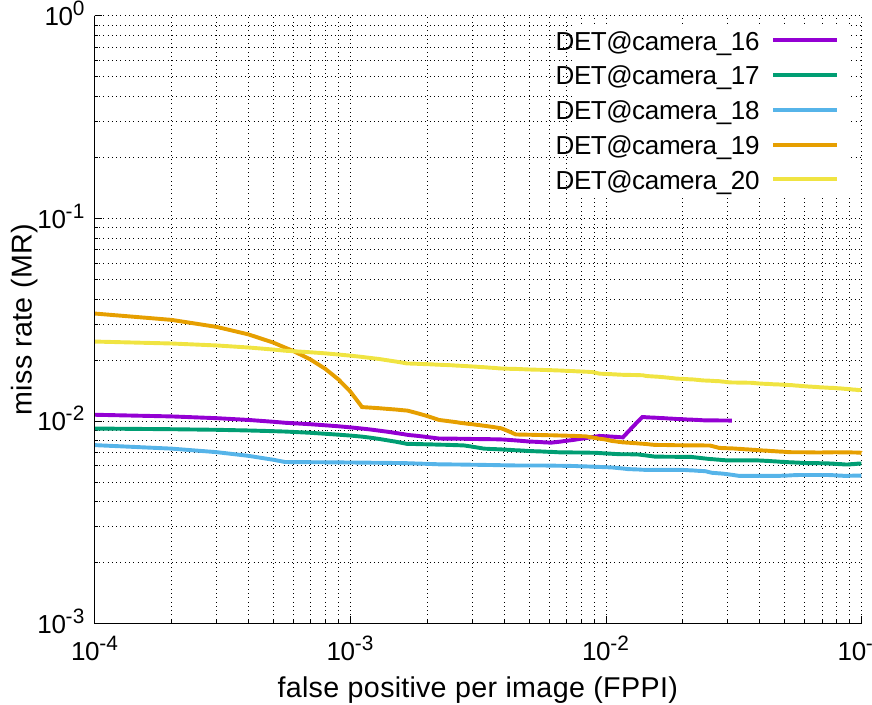
Figure 29. DET curves @ Cameras_16–20, informed-filters, some